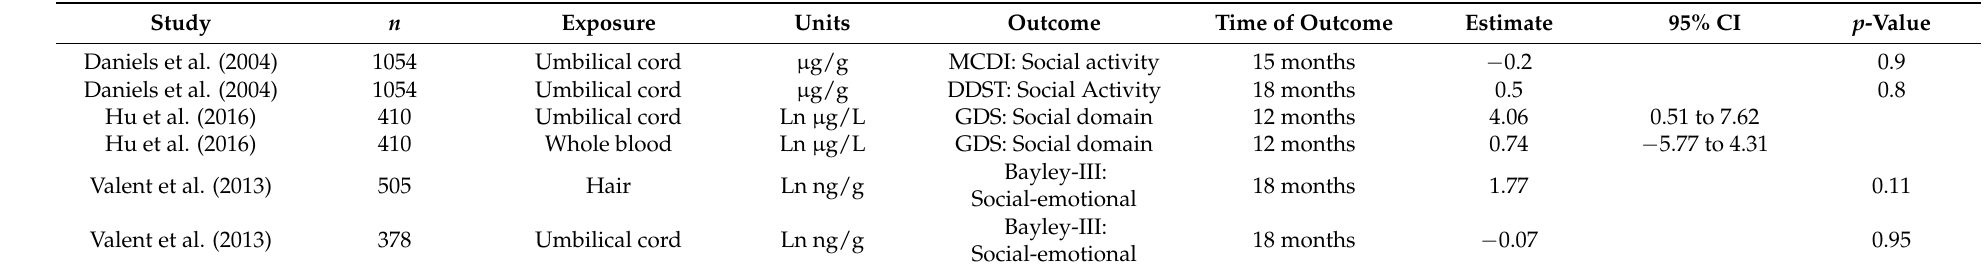
Table 8. Results from studies identified as high quality which measured social development ( n = 3).